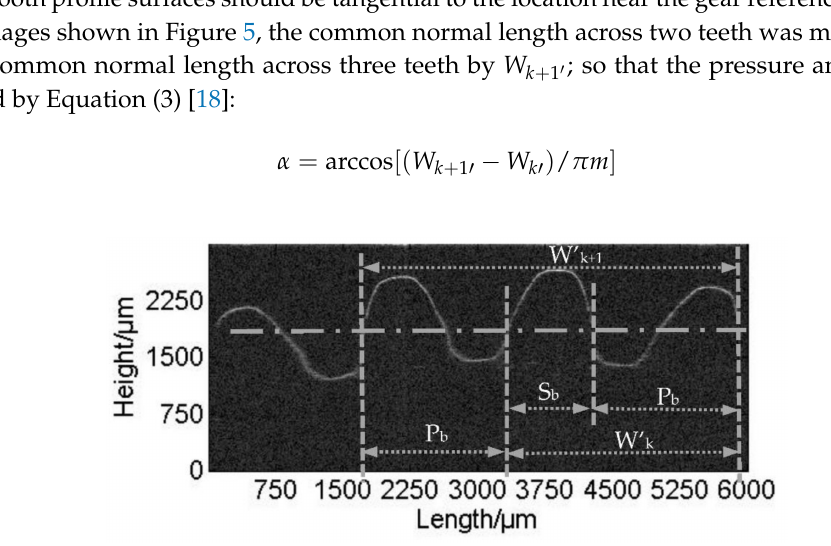
Figure 5. Calculation of pressure angle, modification coefficient, and tooth thickness using optical coherence tomography imaging by any three teeth. W k (cid:48) : the common normal length across two teeth. W k+1 (cid:48) : the common normal length across three teeth. S b : tooth thickness. P b : pitch of the